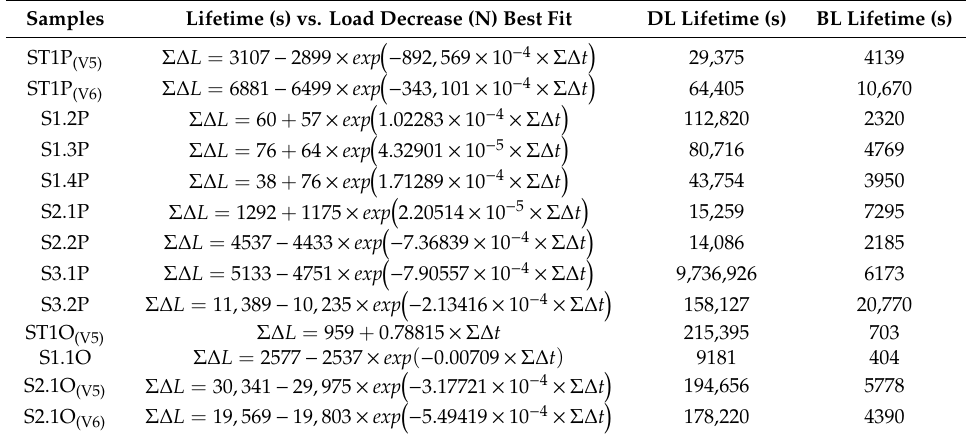
Table 2. Total expected lifetime for the ductile-like (DL) and brittle-like (BL) state for the simil-CT oak and pine samples and the best fit of lifetime versus load decrease (BL fracture mechanism). V5, Vallen sensor number 5; and V6, Vallen sensor number